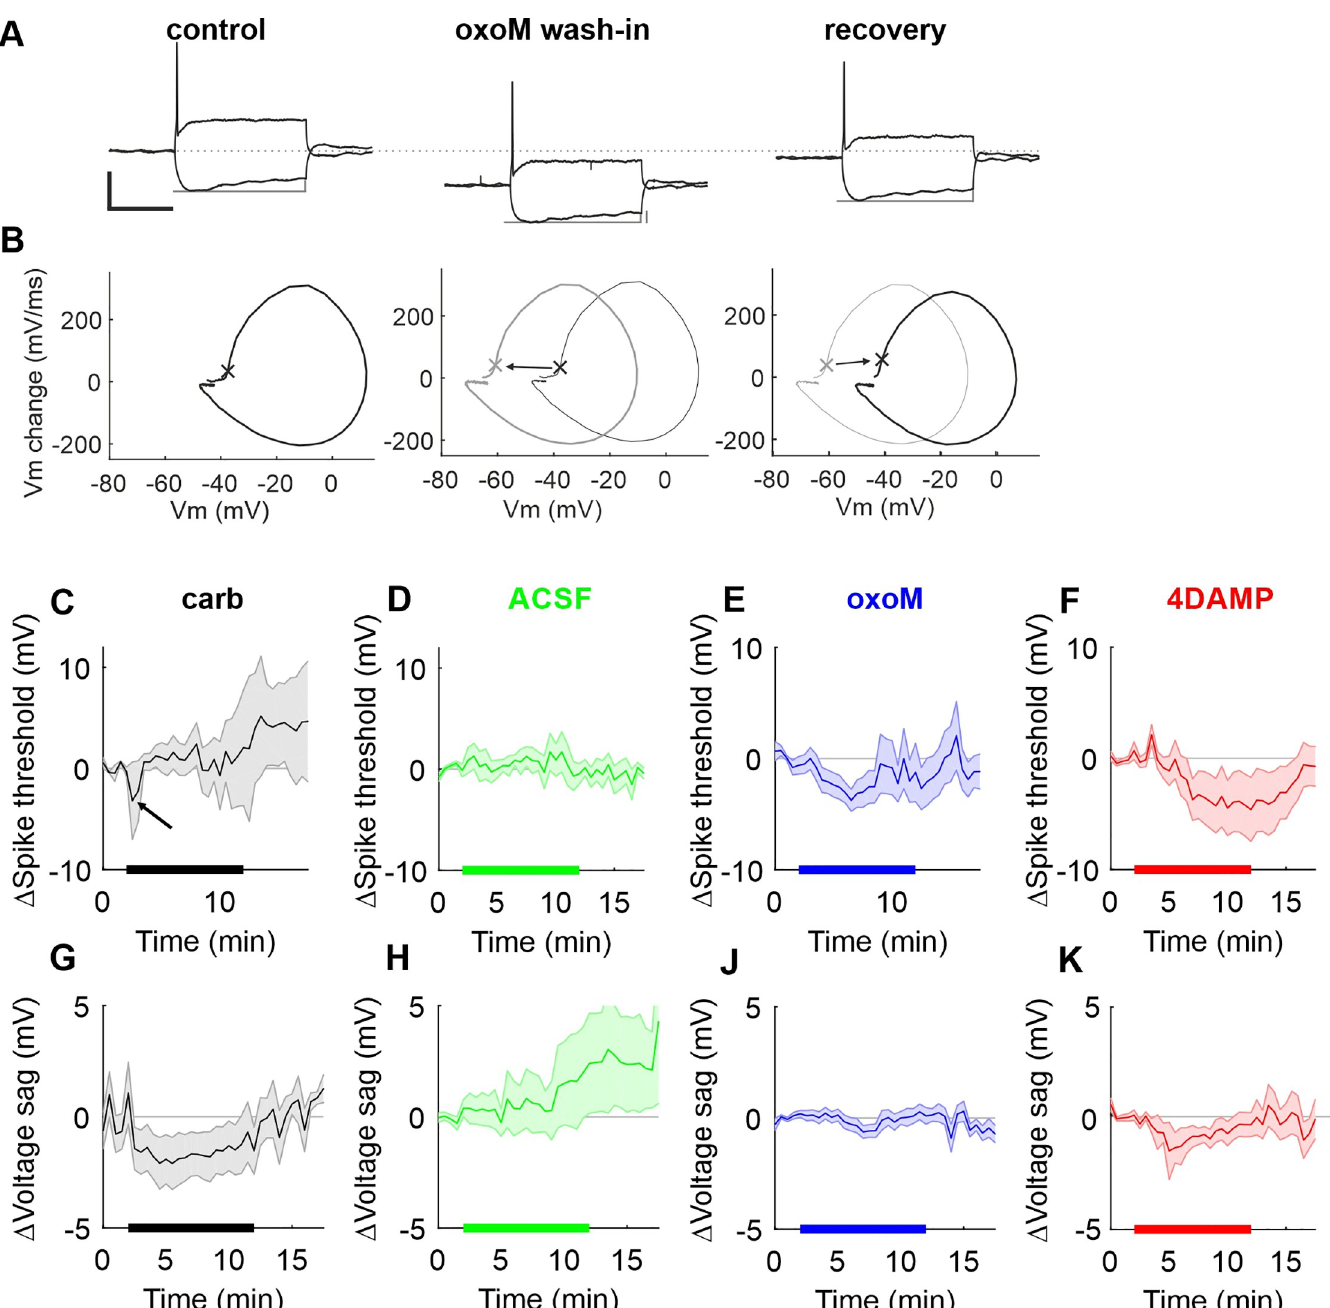
Fig 10. AP threshold and voltage sag monitoring during application of cholinergic compounds. (A) Voltage response to de- and hyperpolarizing current injections in control (left), during (middle; wash-in) oxotremorine-M perfusion and after (right; recovery) oxotremorine-M perfusion; scale: 50 ms/25 mV. Thin grey lines illustrate the difference between maximum- and steady-state depolarization, which we analyze here as voltage sag caused by activation of I h . (B) Phaseplane plots illustrating the relation between the rate of change of the membrane potential and the membrane potential during the occurrence of the action potentials shown above. A value of > 50 mV/ms was taken as AP threshold (marked with an x; note that due to the low sample number during the rapid rise the exact value of the threshold can be different in the three plots). It becomes clear that the AP threshold shifts towards hyperpolarized values during oxoM application (middle panel: thick grey line = oxoM, thin black line = control) and recovers after wash-out (right panel: thin grey line = oxoM, thick black line recovery). (C-F) Mean of AP threshold change over time for carbachol (C), ACSF (D), oxotremorine-M (E) and 4DAMP (F). The thicker line on the X axis represents the duration of perfusion. The arrow in C highlights the transient reduction of AP threshold caused by carbachol. (G-K) Mean of voltage sag change over time for carbachol (G), ACSF (H), oxotremorine-M (J) and 4DAMP (K). Shaded areas represent the standard error.